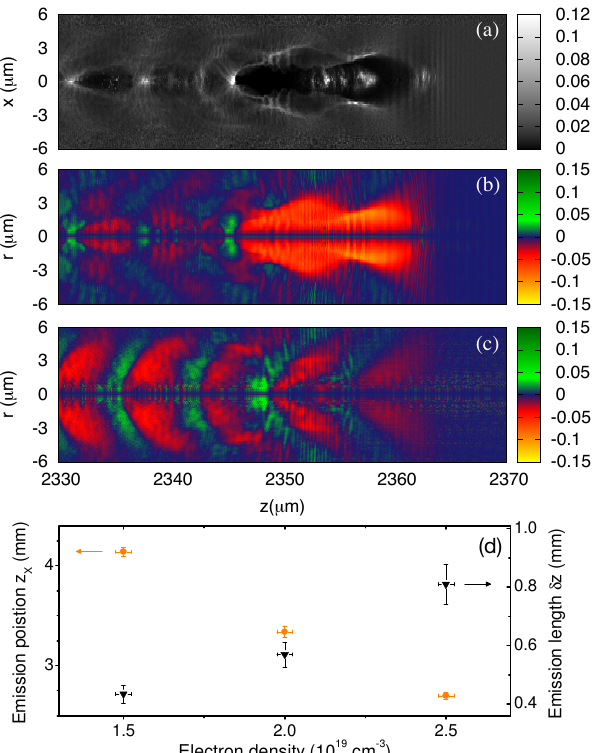
Figure 2. Mode transition: ( a – c ) show a PIC simulation at plasma density of 2.5 × 10 19 cm − 3 , in ( a ) plasma density n e with the injected electron beam, in ( b ) the corresponding normalized transverse force in the wakefield and in ( c ) the transverse wakefield force as generated from the laser pulse only. This shows that, at this point, the wakefield is maintained primarily by the electron beam. In ( d ), experimental results showing that the betatron emission length and, thus, the plasma interaction length is increased with n e at high values of n e , contrary to LWFA scalings and in agreement with an LWFA-PWFA transition that allows for increased emission length at high plasma density (figure adapted from [20]).